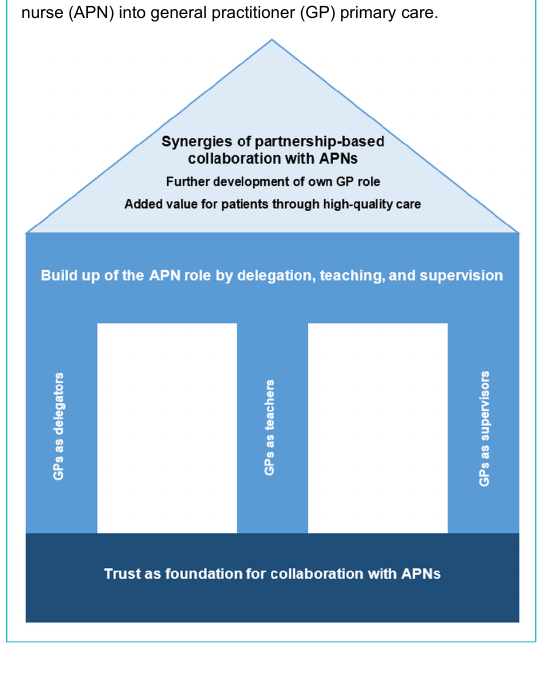
Table 3: Phases according to Braun and Clarke